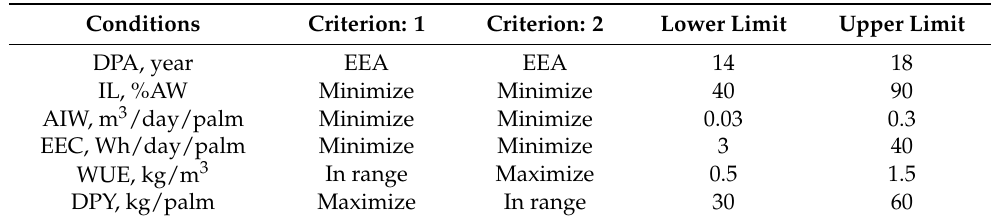
Table 3. Constraints for optimizing irrigation level (IL), applied irrigation water (AIW), electrical energy consumption (EEC), water use efficiency (WUE), date palm yield (DPY) at date palm age (DPA) equal to each age (EEA) of 14, 15, 16, 17, and 18 years, under two criteria.